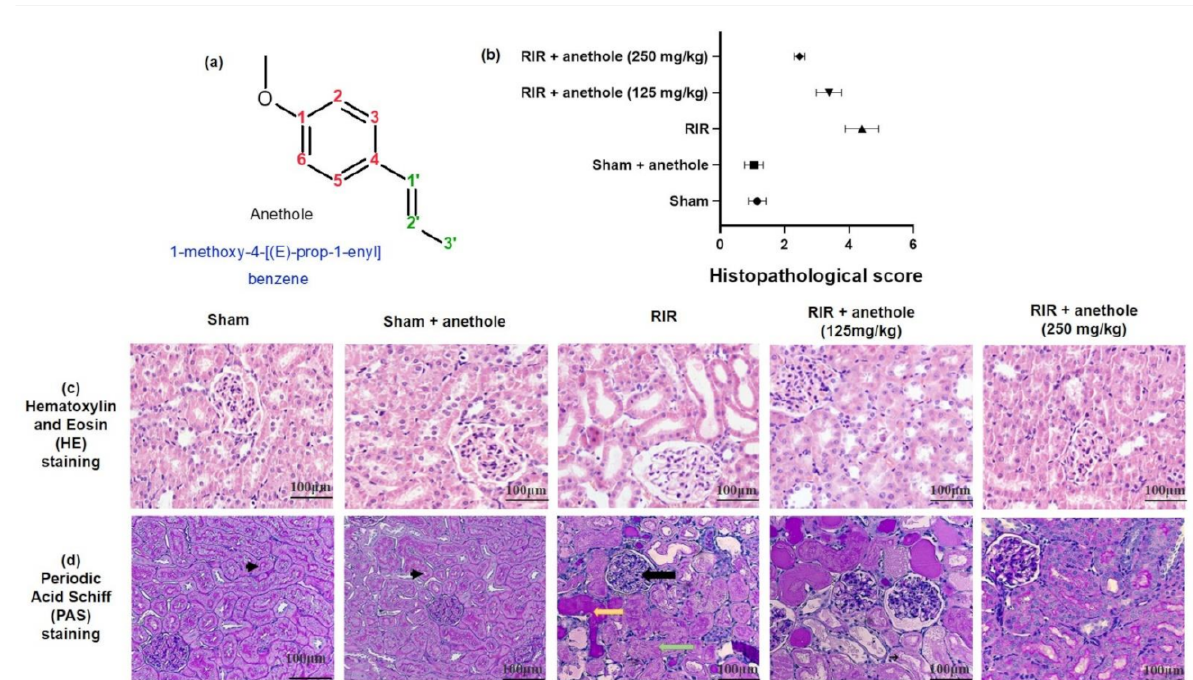
Figure 1. ( a ) Anethole chemical structure, ( b ) quantitative assessment of renal damage score, ( c , d ) histopathological analysis displaying the protective action of anethole (125 and 250 mg/kg) on the renal tissues challenged through RIR stained with hematoxylin and eosin (H&E) and periodic acid Schiff (PAS) stain, respectively. The black arrows show glomeruli collapsed with focal necrosis. The yellow arrow shows hyaline accumulation. The green arrow illustrates the necrotic